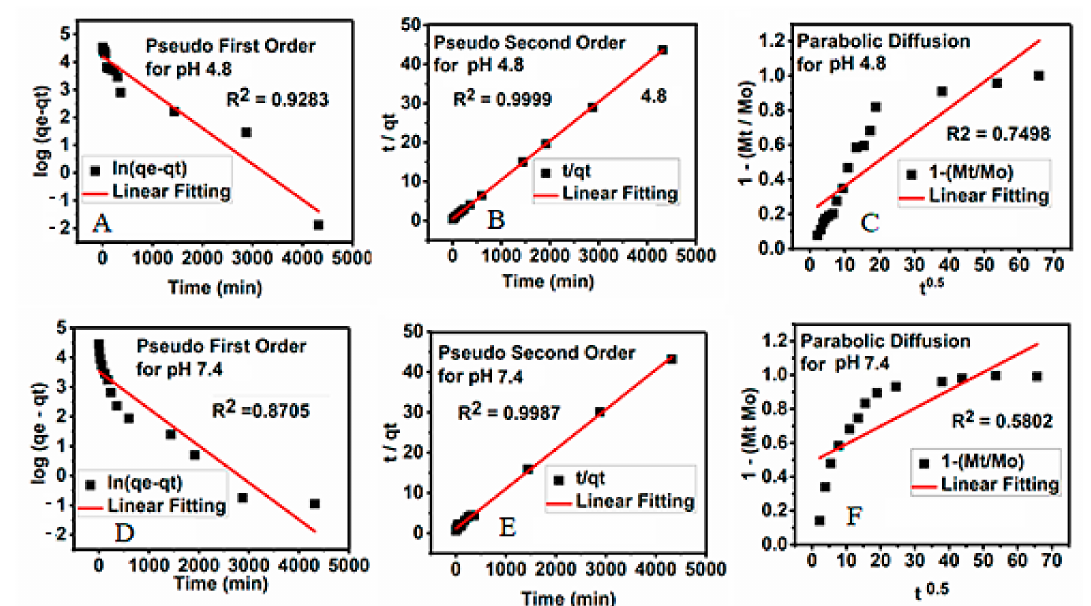
Figure 10. Kinetic parameters for the study of the release of 5-FU from FPVAFU-ZLDH dissolved in dimethyl sulfoxide into different solutions in relation to ( A ) the pseudo-first-order kinetic, ( B ) the pseudo-second-order kinetic, and ( C ) the parabolic diffusion kinetic for pH 4.8, and that dissolved in dimethyl sulfoxide in different solutions in relation to ( D ) the pseudo-first-order kinetic, ( E ) the pseudo-second-order kinetic, and ( F ) the parabolic diffusion kinetic for pH 7.4. Table 5. The correlation coefficient, rate constant, and half-life obtained by fitting the 5-FU release data for the PBS solution at pH 4.8 and pH 7.4. Sample